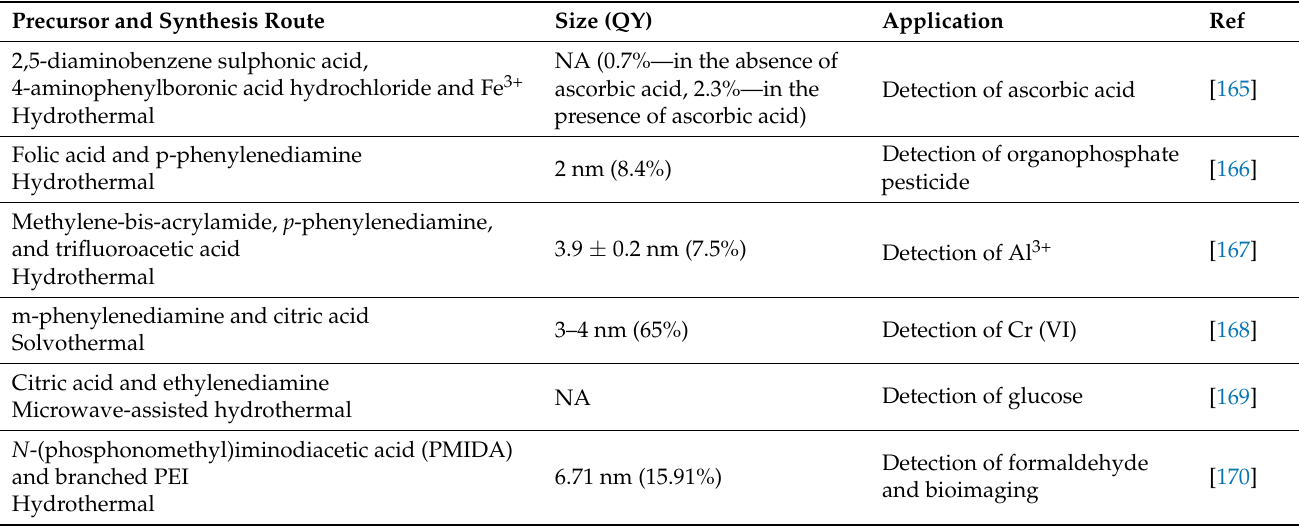
Table 4. CDs synthesized for dual-mode detections (PL and